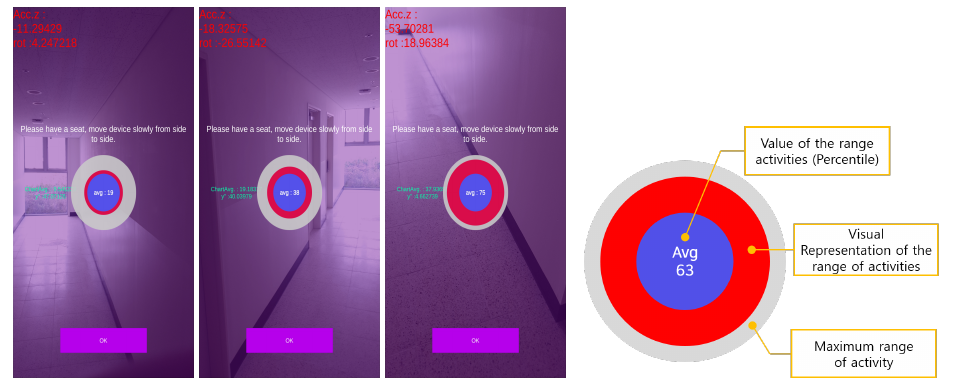
Figure 9. Range of user activities measurement screen.